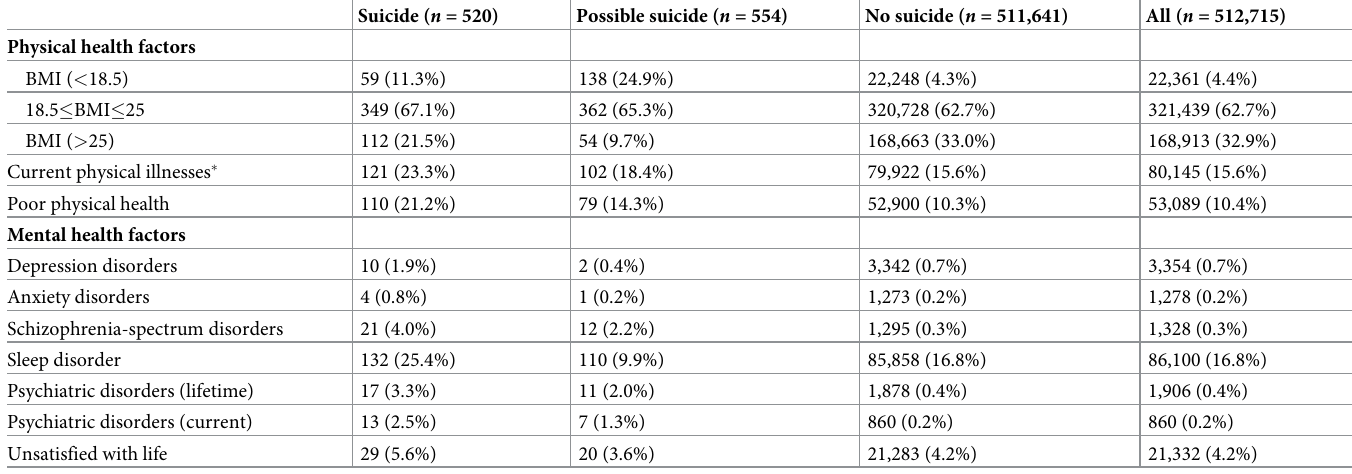
Table 2. Physical and mental health status of participants by suicide status during